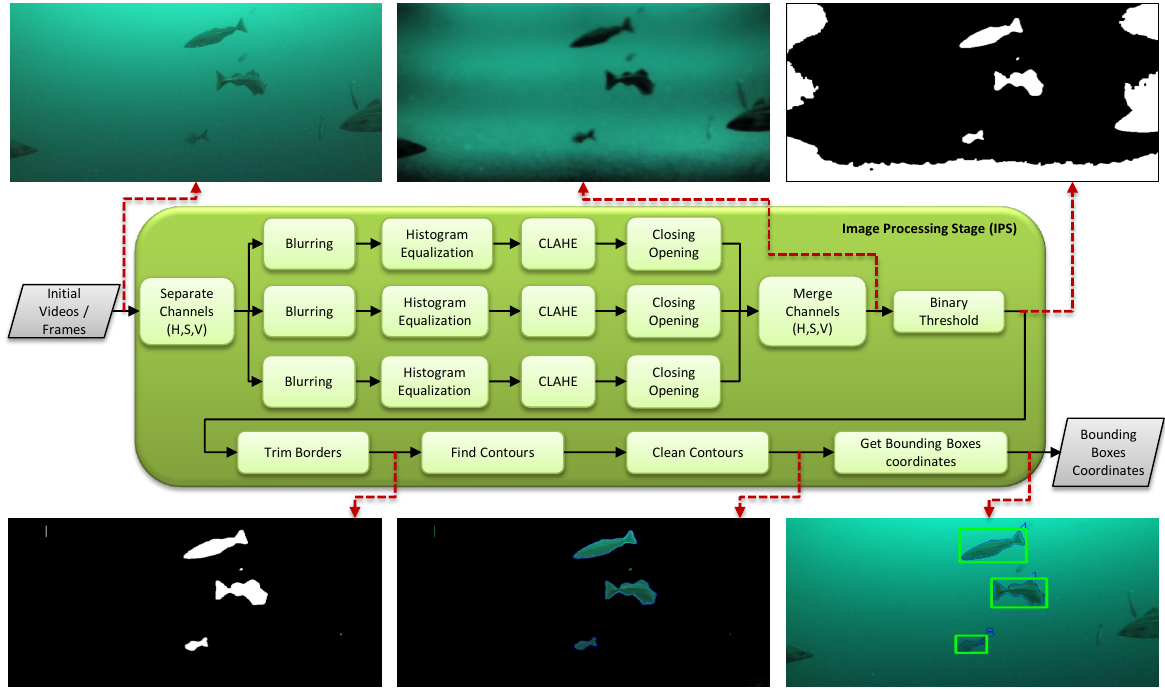
Figure 2: Flow diagram of the image processing stage